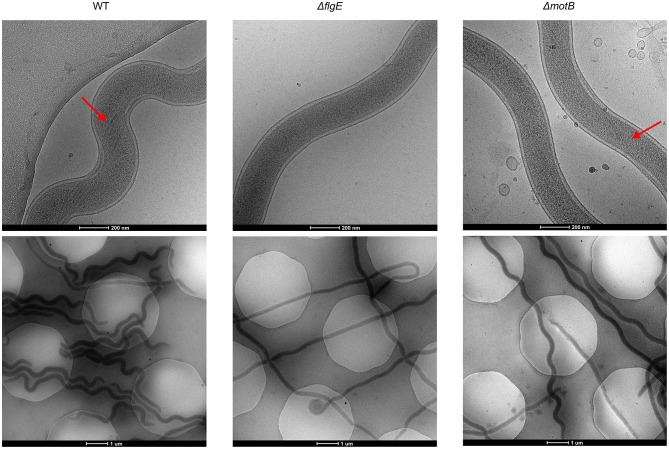
Representative cryo-Electron Microscopy images of T. denticola wild-type, ΔflgE, and ΔmotB. T. denticola cells were grown to exponential phase and viewed directly under cryo-EM. Red arrows point to the periplasmic flagella.